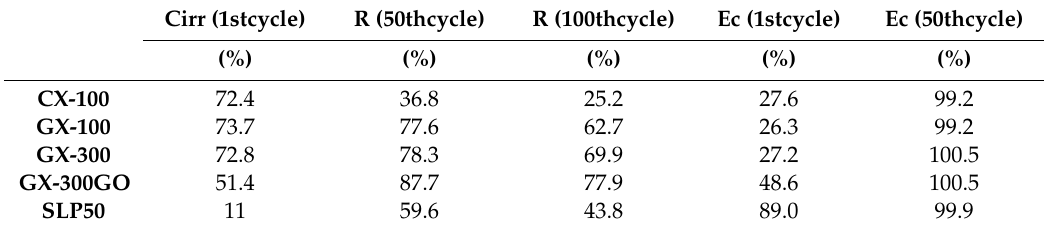
Table 2. Electrochemical parameters from galvanostatic cycling at a rate of C / 5. Cirr (1stcycle) R